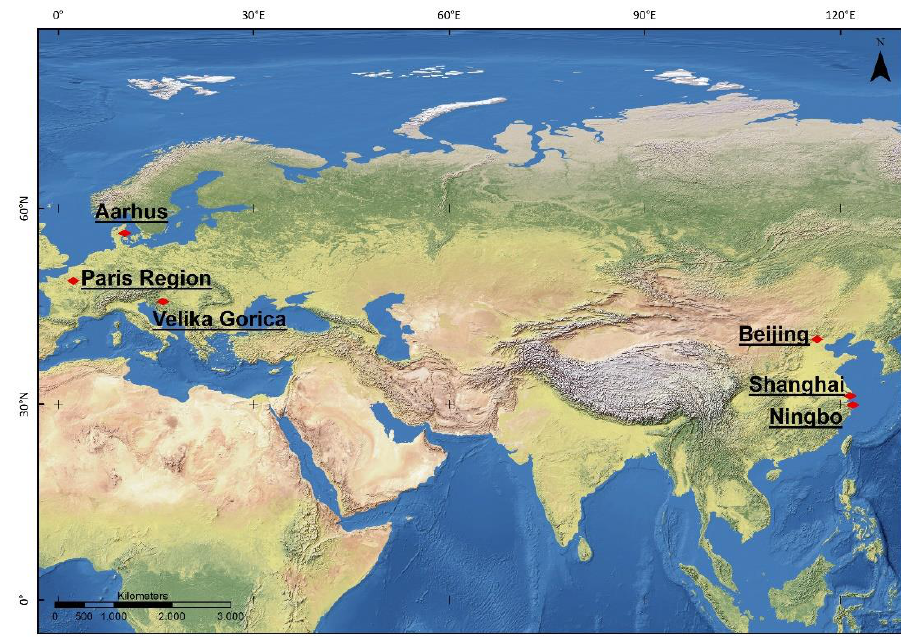
Figure 1. Location of the study areas. Paris Region is the capital region of France with a land area of 12,012 km 2 , home to 12 million inhabitants or 18.2% of the population of France. 21% of the territory is urbanised (16% totally impermeable), 23% covered by forests and 47% of the territory is composed of cultivated, mainly intensive open field crops. Biodiversity has greatly depleted over the last decade, which is especially visible in agricultural areas and in urban parks and gar- dens. Green space per inhabitant is very scarce in the four départements within the inner ring of the Paris Region—it varies between 2 and 10 m 2 depending on administrative unit. The region experiences substantial land take with more than 900 hectares of rural area consumed each year by urbanisation. City of Aarhus is the second largest city in Denmark with 273,077 inhabitants with a land area of 468 km 2 and a total municipal population of 341,000. The urban area of Aarhus is 91 km 2 and its population density is around 3000 inhabitants per km 2 , compared to an average of 272 people per km 2 for the entire municipality. Over 90% of the inhabitants have access to green space within 500 m and the authorities aim to sustain or increase green area per inhabitant through green/blue structure planning despite densification. The city anticipates densification with an additional 75,000 inhabitants by 2030. City of Velika Gorica is the sixth largest city in Croatia with 63,517 inhabitants and is located in close vicinity to the City of Zagreb, the capital of Croatia. The municipality covers 328 km 2 and has 193 inhabitants per km 2 . In contrast, the urban area covers only around 13 km 2 (ca. 4%) and experienced intensive construction during the 1970s and 1980s. Here, 32,000 inhabitants live with a population density of around 2500 people per km 2 . In the near vicinity, lowland, humid wooded areas host the highest woodland biodi- versity nationally. Beijing is the capital city of China with a land area of 16,410 km 2 . Beijing has gone through a rapid urbanisation process in the past four decades. Beijing’s permanent popu- lation increased from 13.8 million in 2000 to 21.7 million in 2016, while the built-up area expanded from 488 km 2 to 1400 km 2 in the same period. Urban green space accounts for about 821 km 2 , corresponding to 21 m 2 per inhabitant. By the end of 2015 there were 339 registered municipal parks. Shanghai is the largest city in China. It is located on the banks of the Yangtze River Delta in Eastern China and covers a total area of 6340 km 2 . Shanghai has the world’s larg- est port and a population of 24.2 million, including a transient population of more than